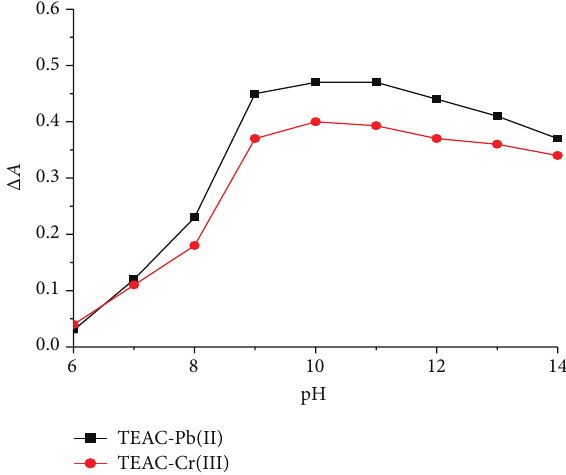
Figure 2: Effect of pH on the change in the absorbance of TEAC- Cr(III) and TEAC-Pb(II)